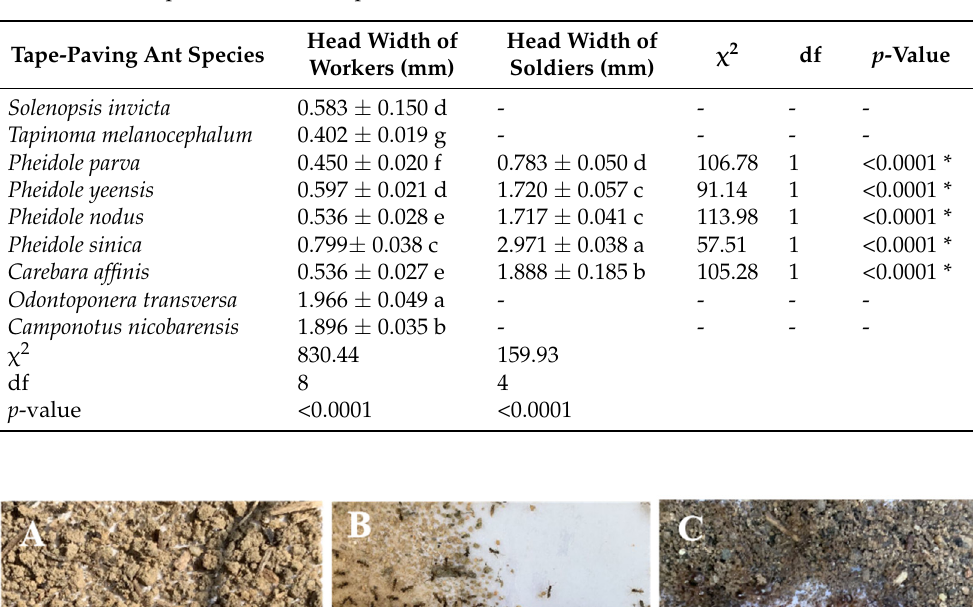
Table 5. Head width (mean ± SE) of nine ants showing tape-paving behavior. Different letters within the same column indicate significant differences among different ant species ( p < 0.05). “*” indicates significant differences between worker and soldiers for each ant species ( p < 0.05). “-” indicates no soldier caste was presented for this species.